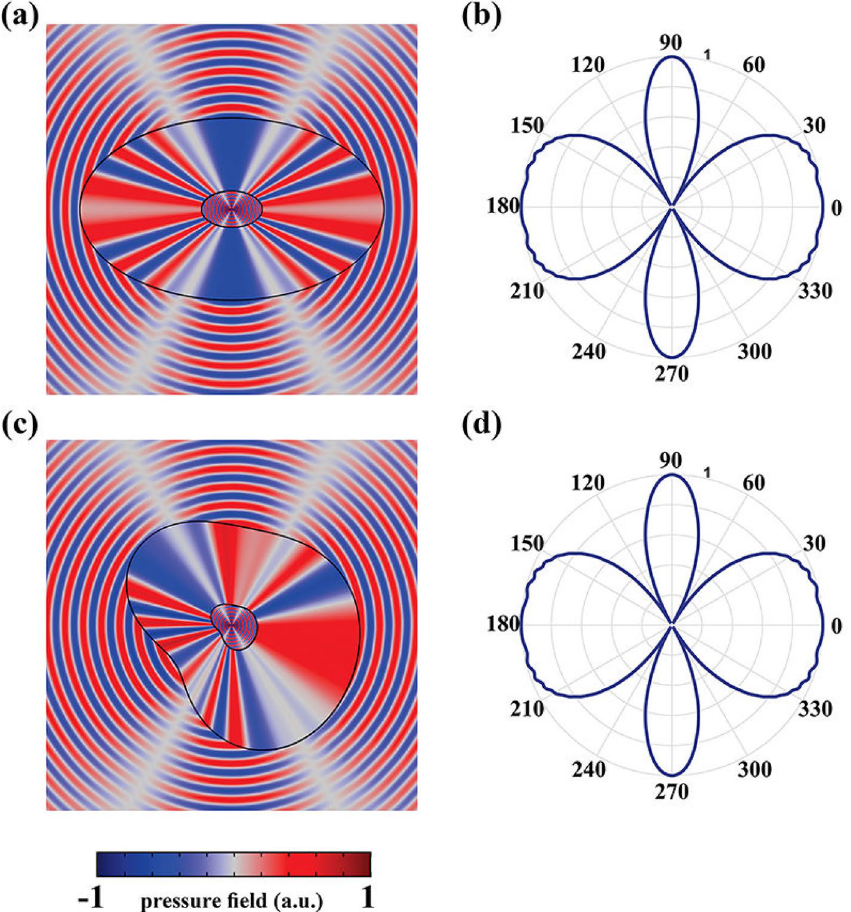
Figure 4. ( a , b ) The normalized near and far field results of the elliptical shape magnifying lens. ( c , d ) The same results of the same sources for a lens with an arbitrary shape cross-section. For both simulations, the material